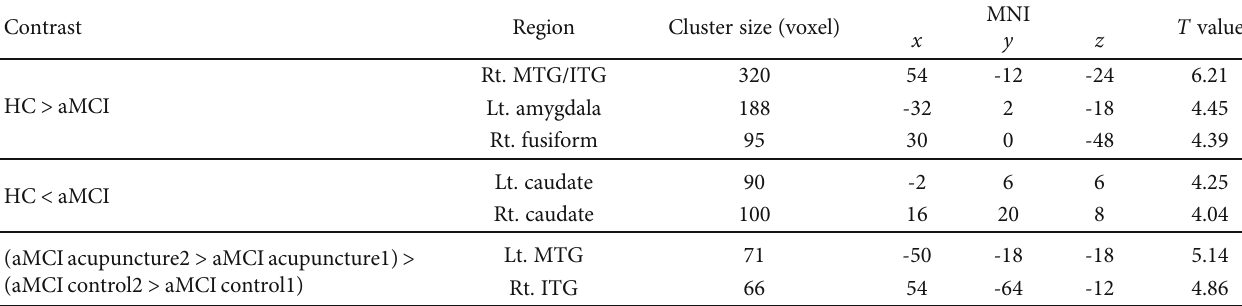
Table 2: Signi fi cant between-group di ff erences in functional connectivity of the right hippocampus. Contrast